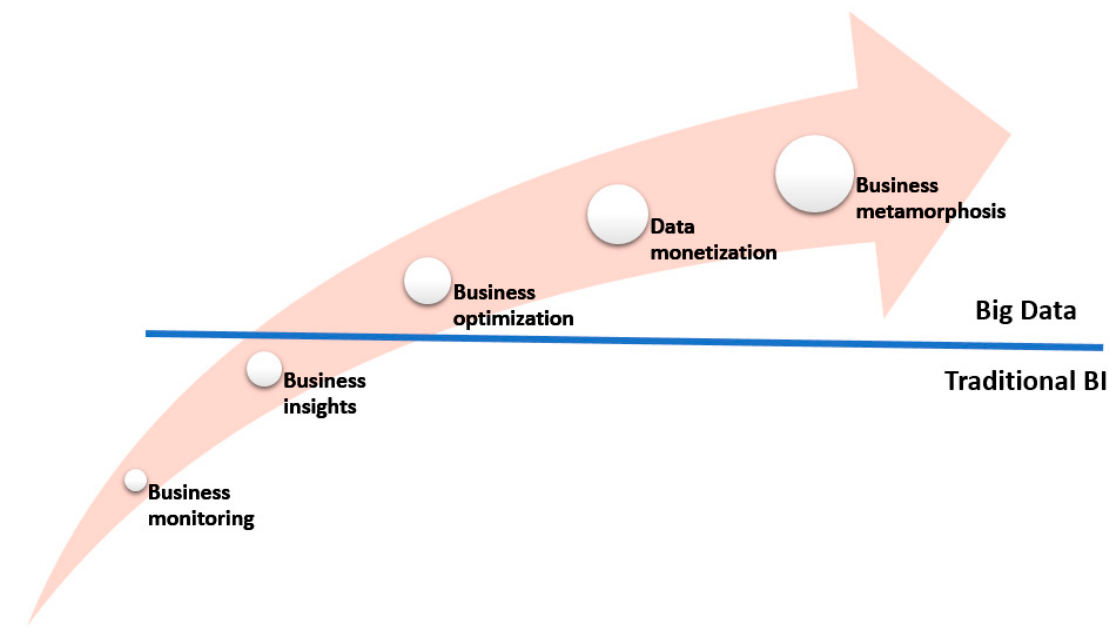
Figure 9. Big Data Business Model Maturity Index.